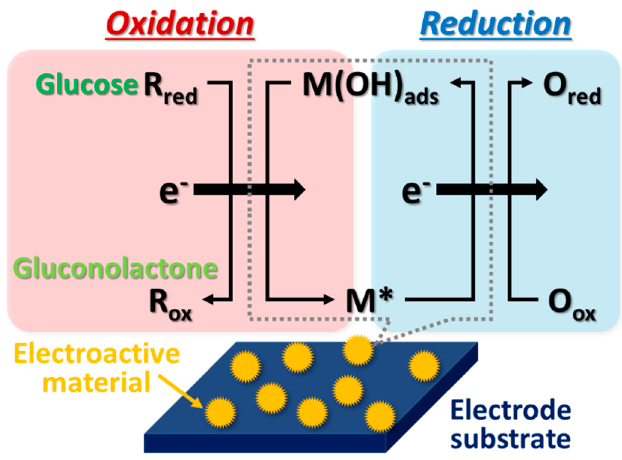
Figure 5. An illustration for the overall reactions of the glucose - sensing by the mechanism of the Incipient Hydrous Oxide Adatom Mediator (IHOAM) on non - enzymatic electrodes.